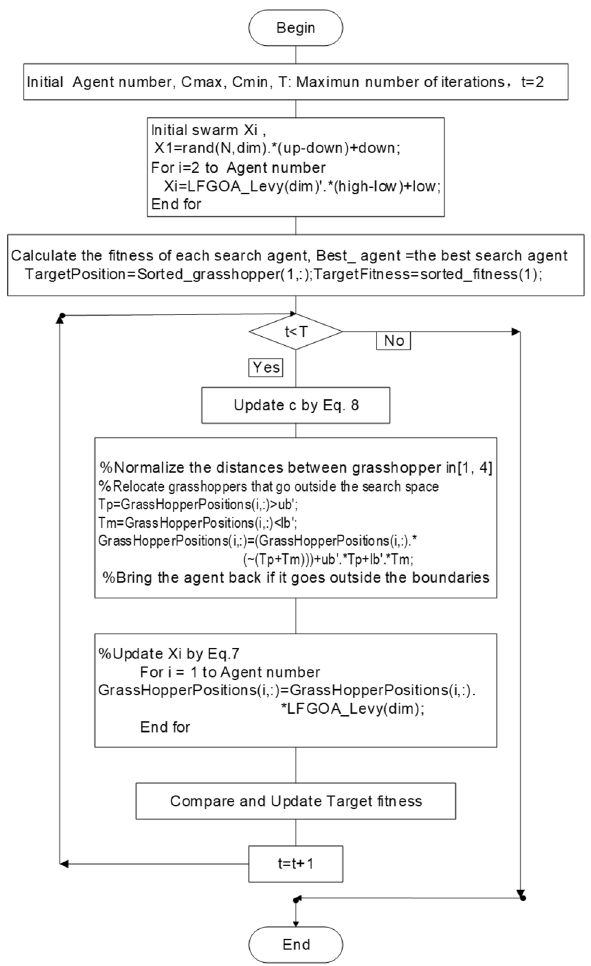
Figure 2. The flow chart of the LFGOA